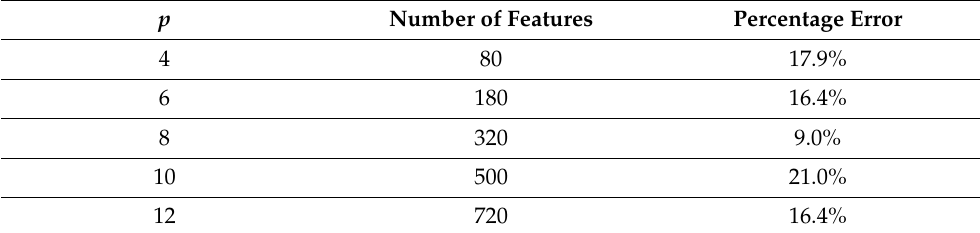
Table 8. Error corresponding to different polynomial orders.